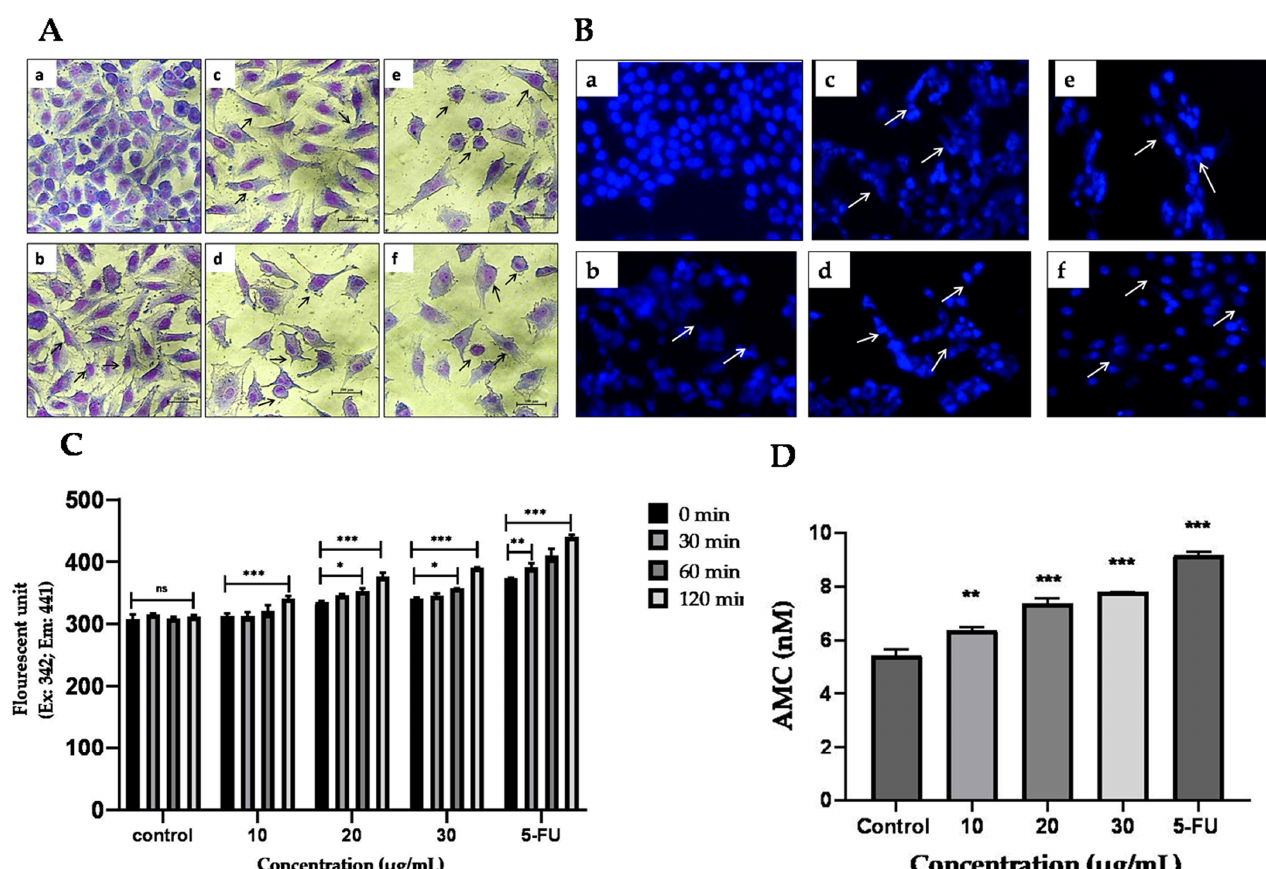
Figure 7. Morphological detection of apoptosis through Giemsa ( A ) and DAPI ( B ) staining. HCT 116 cells were treated with TYH and 5-FU for 48 h, ( a ) Control (non-treated), ( b ) 30 µ g/mL, ( c ) 60 µ g/mL, ( d ) 90 µ g/mL, ( e ) 120 µ g/mL, and ( f ) 5-FU (10 µ g/mL) and changes in cell morphology were examined. Further effect of TYH on caspase-3 enzyme activity in HCT 116 cells after 48 h of treatment was checked using EnzChek ® Caspase-3 Assay Kit. ( C ). Time-dependent increase in caspase-3 enzyme activity after treatment with TYH for 48 h. ( D ) Quantification of AMC release in cells treated with TYH after an incubation time of 120 m. Results represent mean ± SD ( n = 3), where *** p < 0.001; ** p < 0.01; * p < 0.05 vs. control.